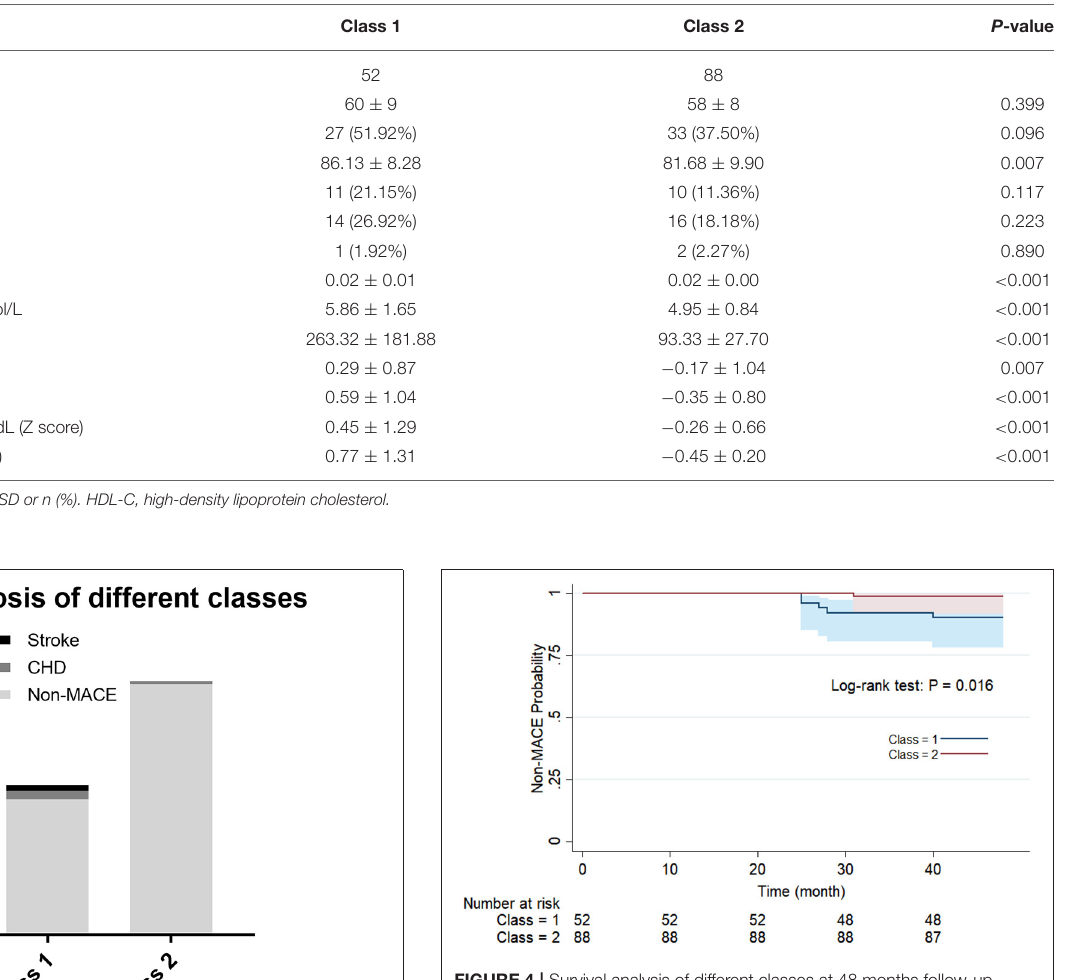
FIGURE 4 | Survival analysis of different classes at 48 months